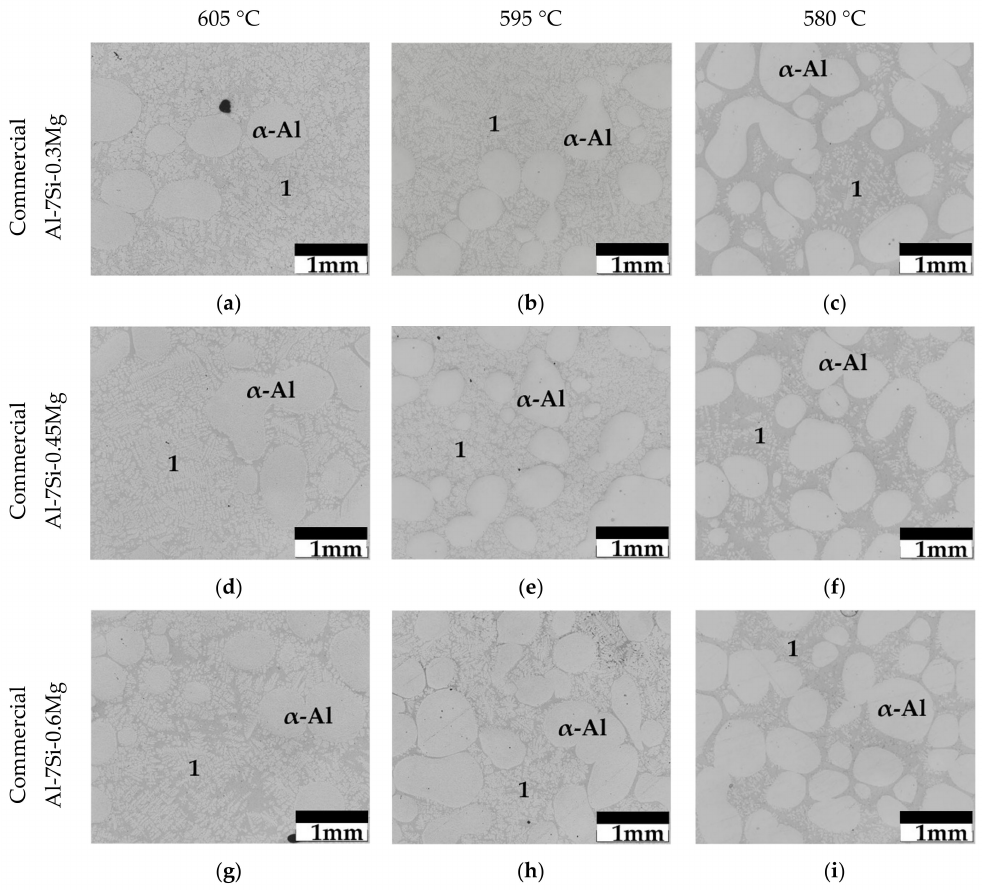
Figure 3. Micrographs of the commercial Al-7Si-Mg alloys quenched after isothermally holding for 120 h at temperatures between the nucleation of the first solid and main Al-Si eutectic reaction: ( a–c ) Al-7Si-0.3Mg, ( d–f ) Al-7Si-0.45Mg and ( g–i ) Al-7Si-0.6Mg. Region 1: primary α -Al dendrites +